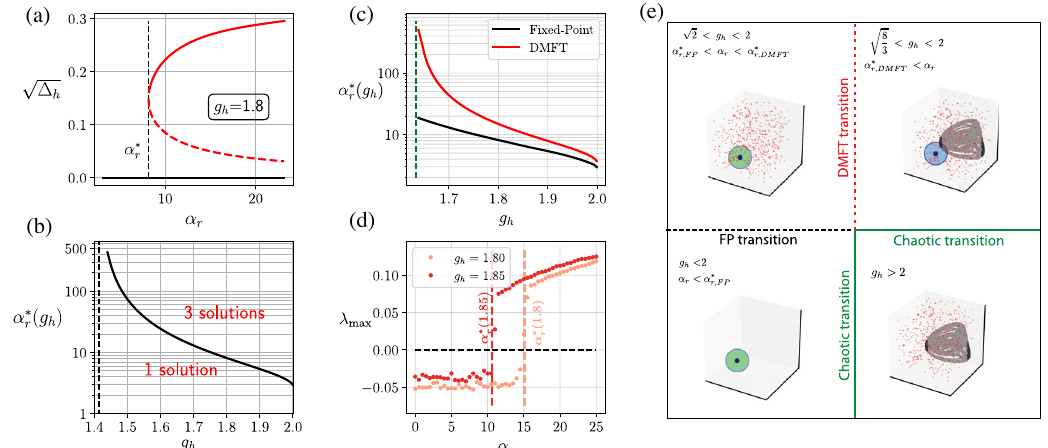
FIG. 4. The discontinuous dynamical transition. (a) Spontaneous appearance of nonzero solutions (dashed and solid red lines) to the FP equations once α crosses a critical value α (cid:3) ð g h Þ at fixed g h . (b) The critical α (cid:3) ð g h Þ as a function of g h . The vertical dashed line ffiffiffi r r; FP r; FP p 2 represents left critical value g , below which a bifurcation is not possible. (c) The critical DMFT transition curve α (cid:3) c ¼ curve) calculated using Eqs. (G8) and (G9). The FP transition curve from (b) is shown in black. The green dashed line corresponds to ffiffiffiffiffiffiffiffi p 8 = 3 g , below which the dynamical transition is not possible. (d) Numerically calculated maximum Lyapunov exponent λ c ¼ function of α for two different values of g . The dashed lines correspond to the DMFT prediction for the discontinuous transition from r h < 2 and α < α (cid:3) (c). (e) Schematic of the bifurcation transition: For g , the zero FP is the only (stable) solution (bottom left box); for ffiffiffi h r r; FP p 2 < g < 2 and α (cid:3) < α < α (cid:3) , the zero FP is still stable, but there is a proliferation of unstable FPs without any obvious ffiffiffiffiffiffiffiffi p h r r; FP r; DMFT 8 = 3 < g < 2 and α > α (cid:3) dynamical signature (top left); for , chaotic dynamics coexist with the stable FP and this transition is h r r; DMFT > 2 . 0 , the stable FP becomes unstable, and only the chaotic attractor remains; this transition is discontinuous (top right); finally, for g h continuous (bottom